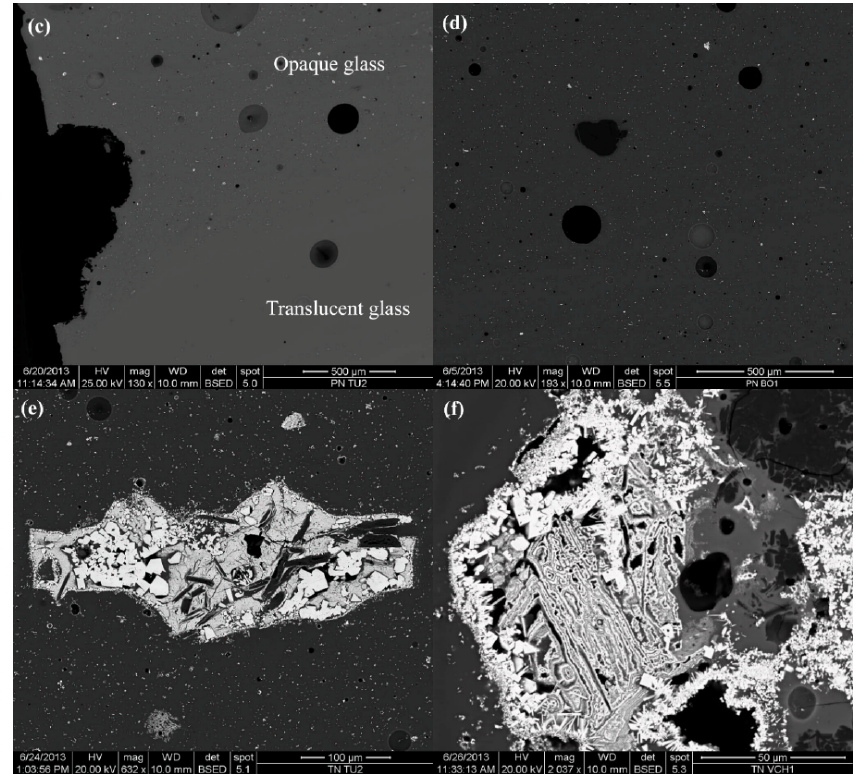
Figure 3. SEM-BSE images of the Ca-antimonate opacified tesserae showing: ( a ) morphology of the Ca-antimonate crystals (tessera PN BIOP1); ( b ) uneven distribution of Ca-antimonates (TN BO1); ( c ) banded micro-texture composed of strips of opaque glass in a translucent matrix (PN TU2); ( d ) homogenous distribution of Ca-antimonates in glassy matrix (PN BO1); ( e ) lump of partly reacted Ca-antimonate associated with newly formed crystals (TN TU2); ( f ) lump of Ca-antimonates with areas characterized by “rosary shaped” aggregation surrounded by larger euhedral crystals (TN VCH1).